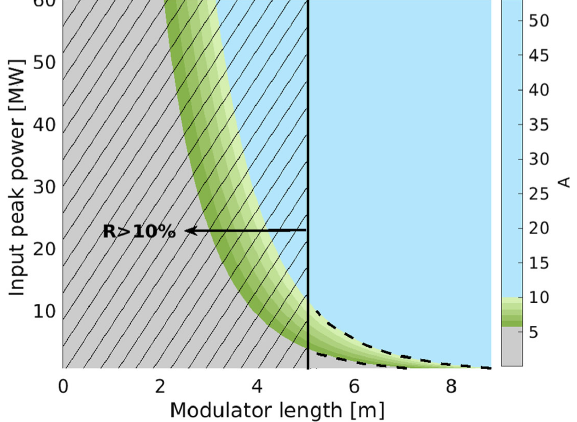
FIG. 2. Overview of possible modulator lengths and seed laser powers. The color bar shows the range of normalized energy modulation that is useful ( 5 . 5 ≤ A ≤ 10 ) in shades of green. The grey and light blue areas of the color bar correspond to non acceptable values of energy modulation. The modulator length for which the power gain is not sufficient to cover resonator losses that are above 90% is also excluded and is shown in the plot with the diagonal black stripes. The small space of input peak power and modulator length combinations that is meeting all the requirements lies in between the two dashed black lines, and the vertical black line. As a result, the minimum possible modulator length is 5 m.